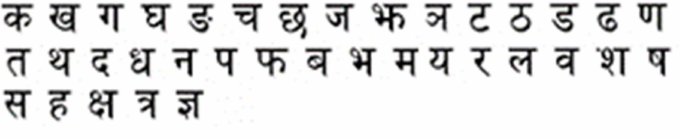
Figure 1. Consonant set of the Hindi